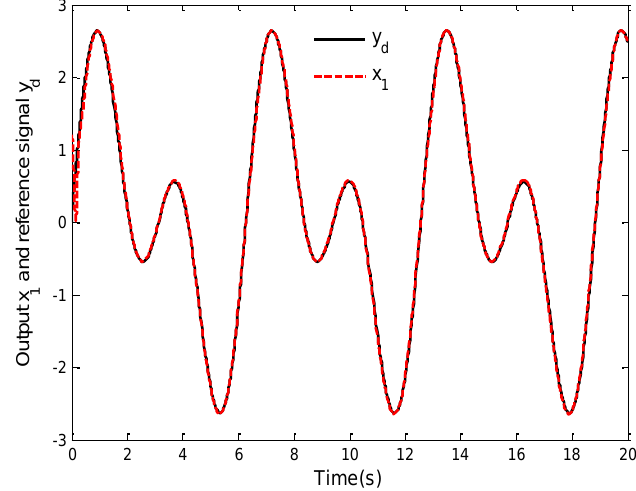
Figure 1. Curves of tracking performance.